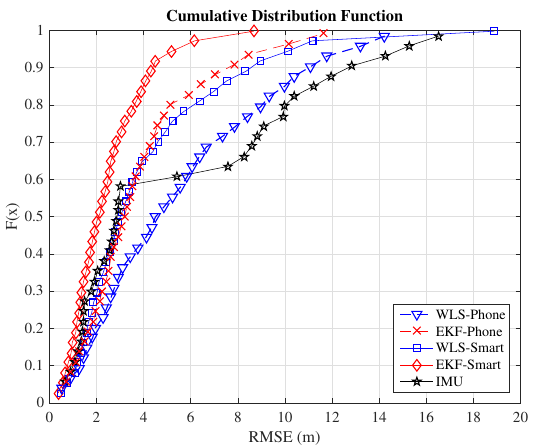
Figure 8. CDF of the positioning estimation error in Path 1.